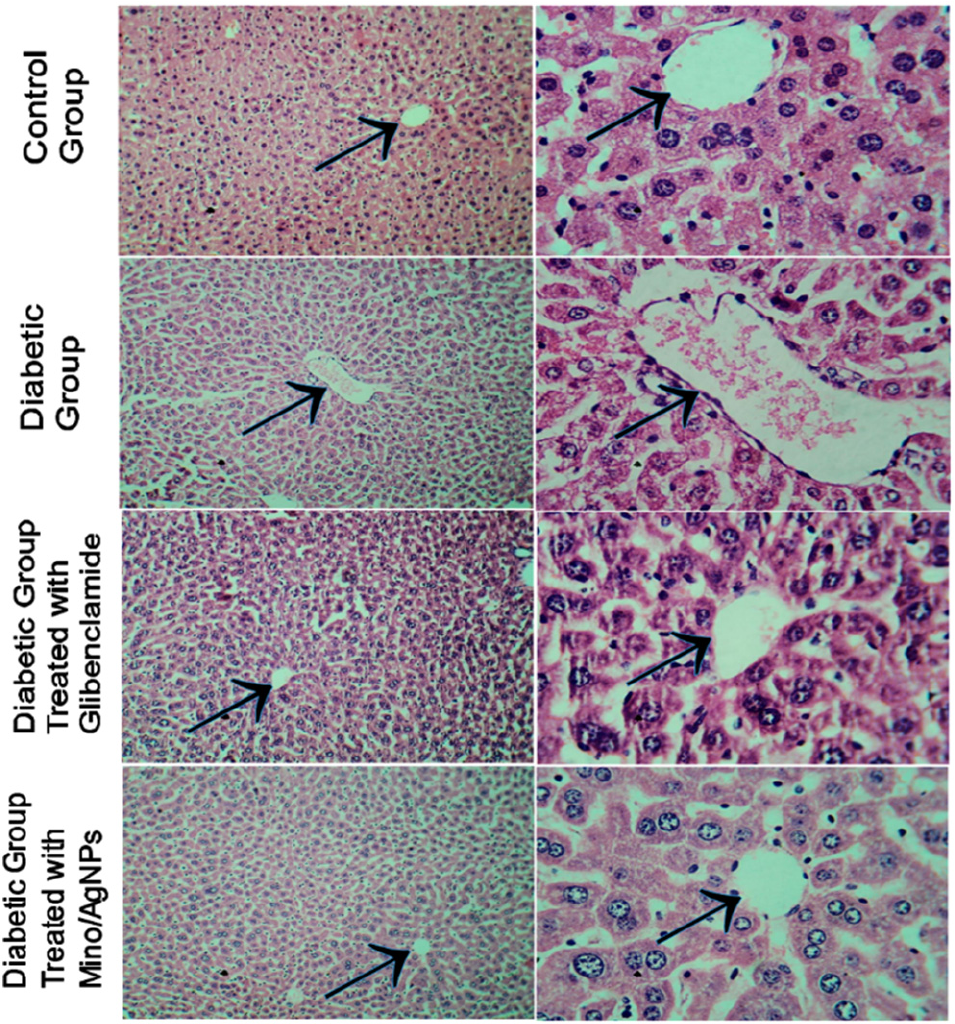
Figure 13. Histopathology of liver sections of various study groups (arrowhead pointing towards the central hepatic vein of the liver).